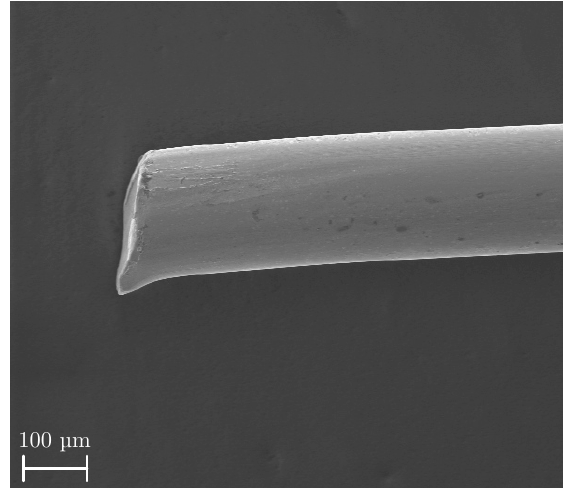
Figure 6. Plastic deformation of the fibre end due to the cutting process (steel fibre type 1).